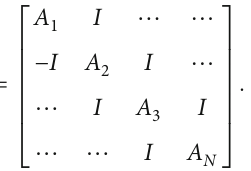
Figure 2: Schematic diagram of the intrinsic structure relationship for non-Newtonian fl